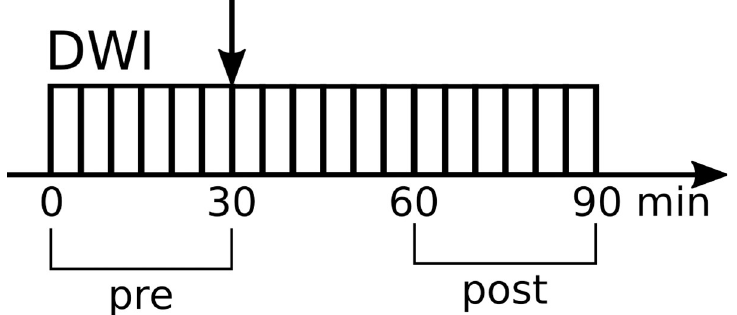
Fig 1. Schematic figure of MRI experiment protocol. The vertical arrow indicates the saline or TGN-020 injection. DWI, diffusion weighted MRI; NR, number of repetitions. Horizontal arrow indicates the timeline.